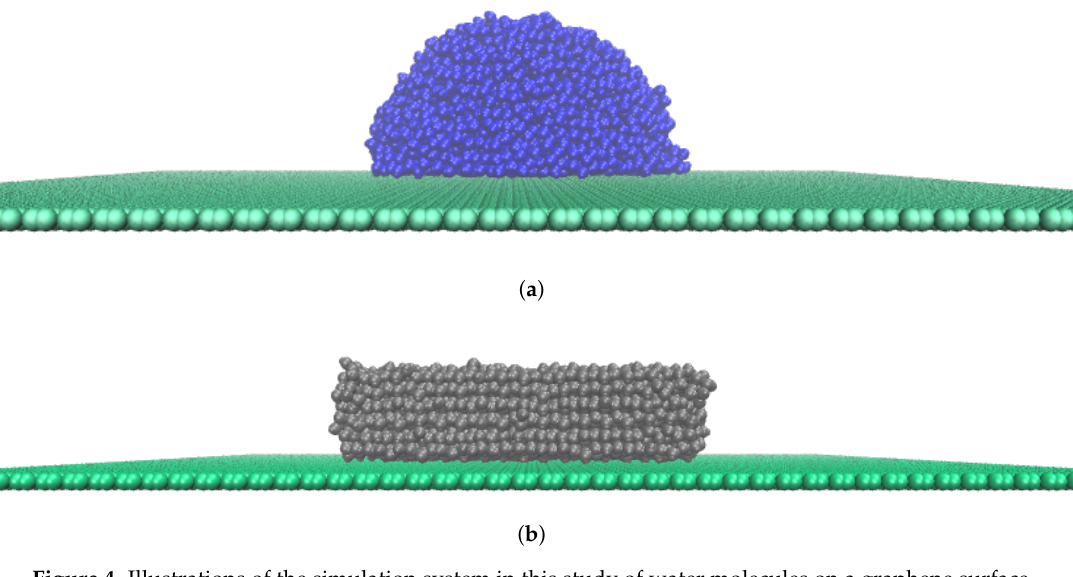
Figure 4. Illustrations of the simulation system in this study of water molecules on a graphene surface, here represented by System A. This system had interaction potential ε 0 = 2.9288 × 10 − 1 kJmol − 1 nm − 2 . ( a ) Water drop at T = 275K; ( b ) Ice cube at T = 180K. Table 1. Overview of the energy well depths, or interaction energies, ε , applied in the seven different simulation systems to change the water contact angle. All systems were simulated five times to obtain